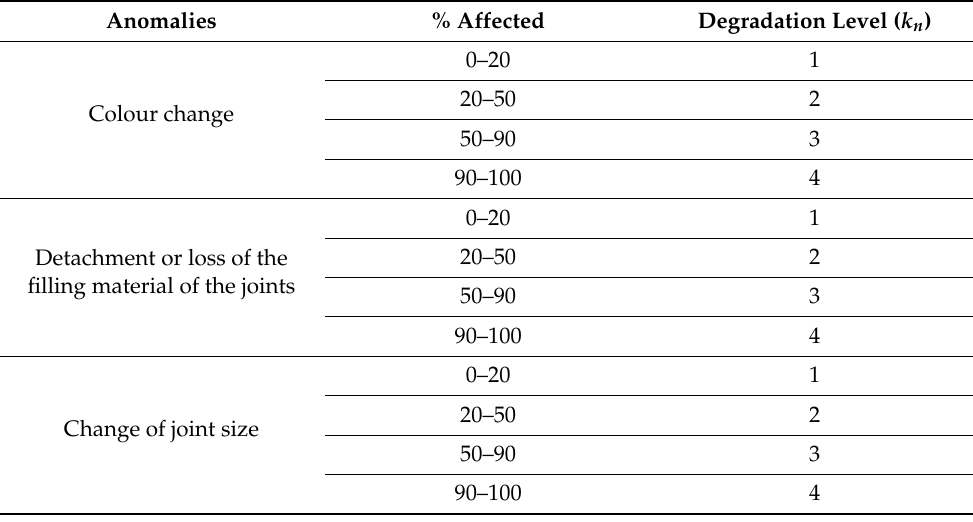
Table 2. Degradation level of joint